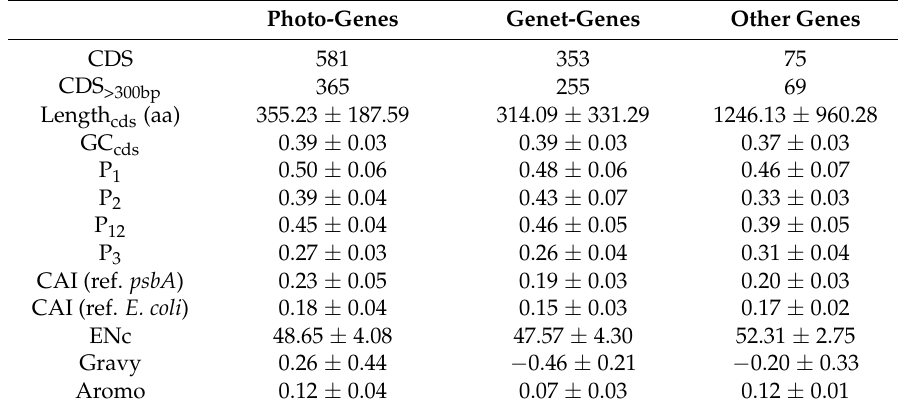
Table 2. Features of three gene categories (Photo-, Genet-, and Other-genes) of Solanum chloroplast genomes. Photo-Genes Genet-Genes Other Genes CDS